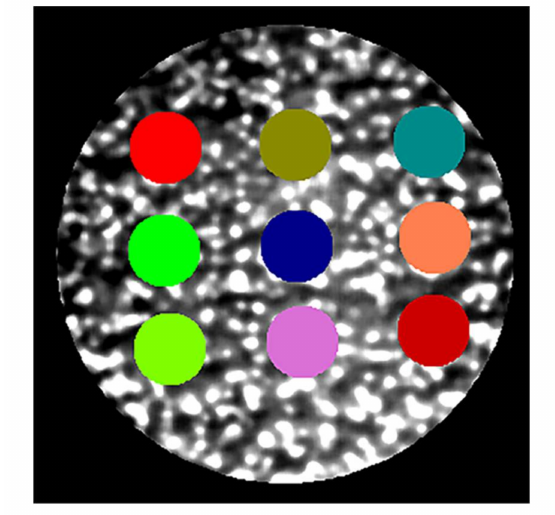
Figure 7. Location of regions of interest (ROI) on a Petri